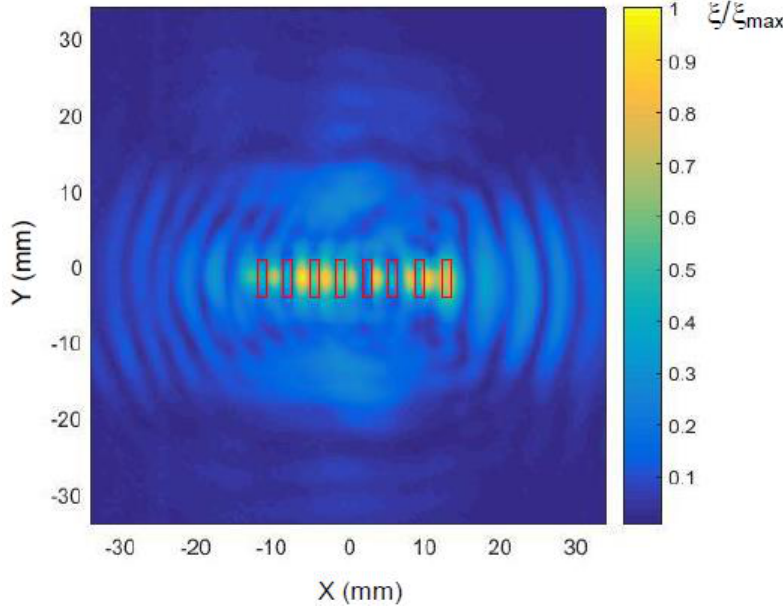
Figure 17. Measured 2D spatial distribution of normal displacements ξ of the plastic film excited by the eight-element phased air-coupled array. The presented amplitude values shown in the color bar were normalized with respect to the maximum value in the field.